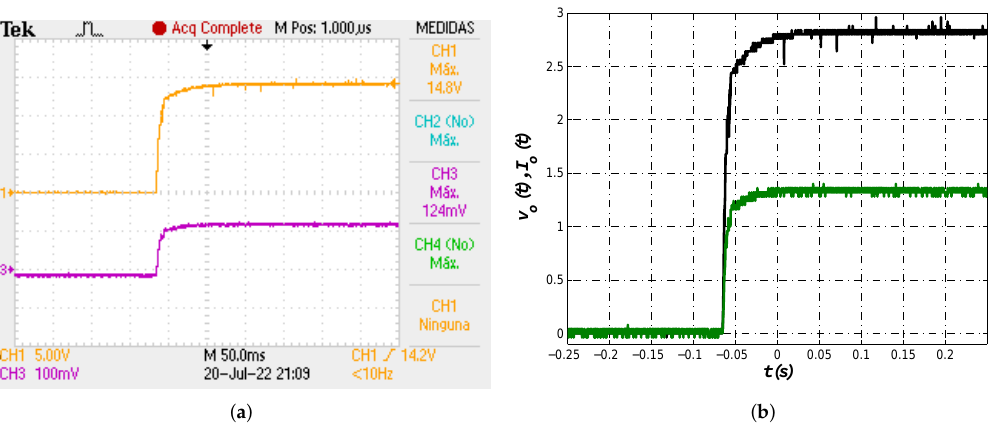
Figure 16. ( a ) Oscilloscope view for measurement of reference tracking characteristic from output voltage v o ( t ) and the corresponding evolution of load current I o ( t ) . ( b ) Alternative view of output voltage v o ( t ) and load current I o ( t ) from exported data, preserving scale of 5 v/unit for v o ( t )